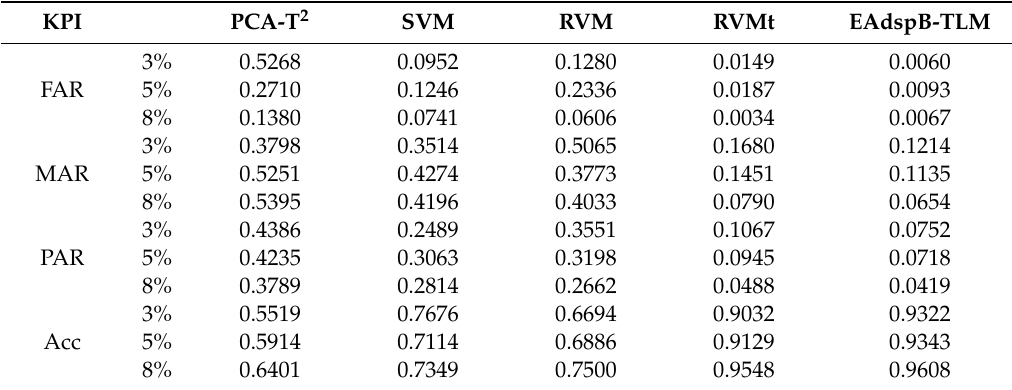
Table 3. Monitoring results for Fault 5.